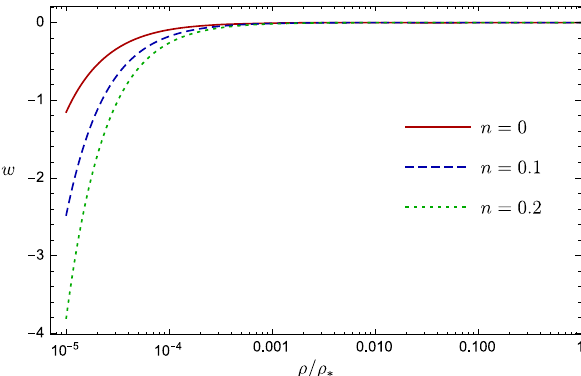
Fig. 2 Equation of state parameter as a function of the density in extended logotropic models (cf. Eq. (6)). The different curves corre-